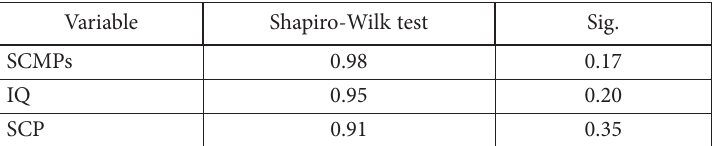
Table 6. Normal distribution test using Shapiro-Wilk test Variable Shapiro-Wilk test Sig. SCMPs 0.98 0.17 IQ 0.95 0.20 SCP 0.91